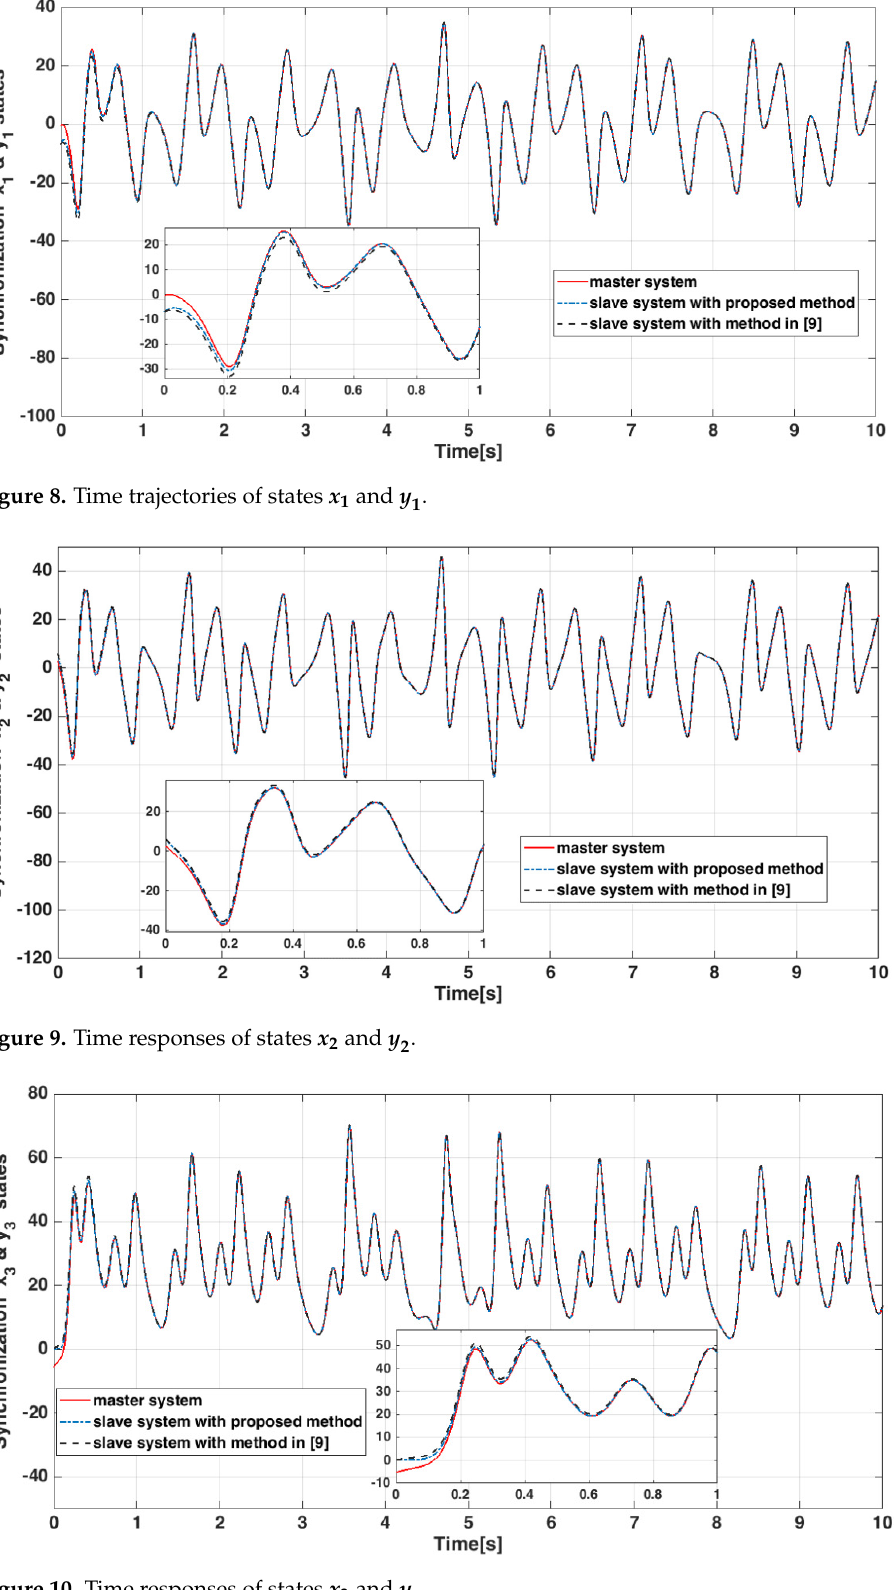
Figure 10. Time responses of states x 3 and y 3